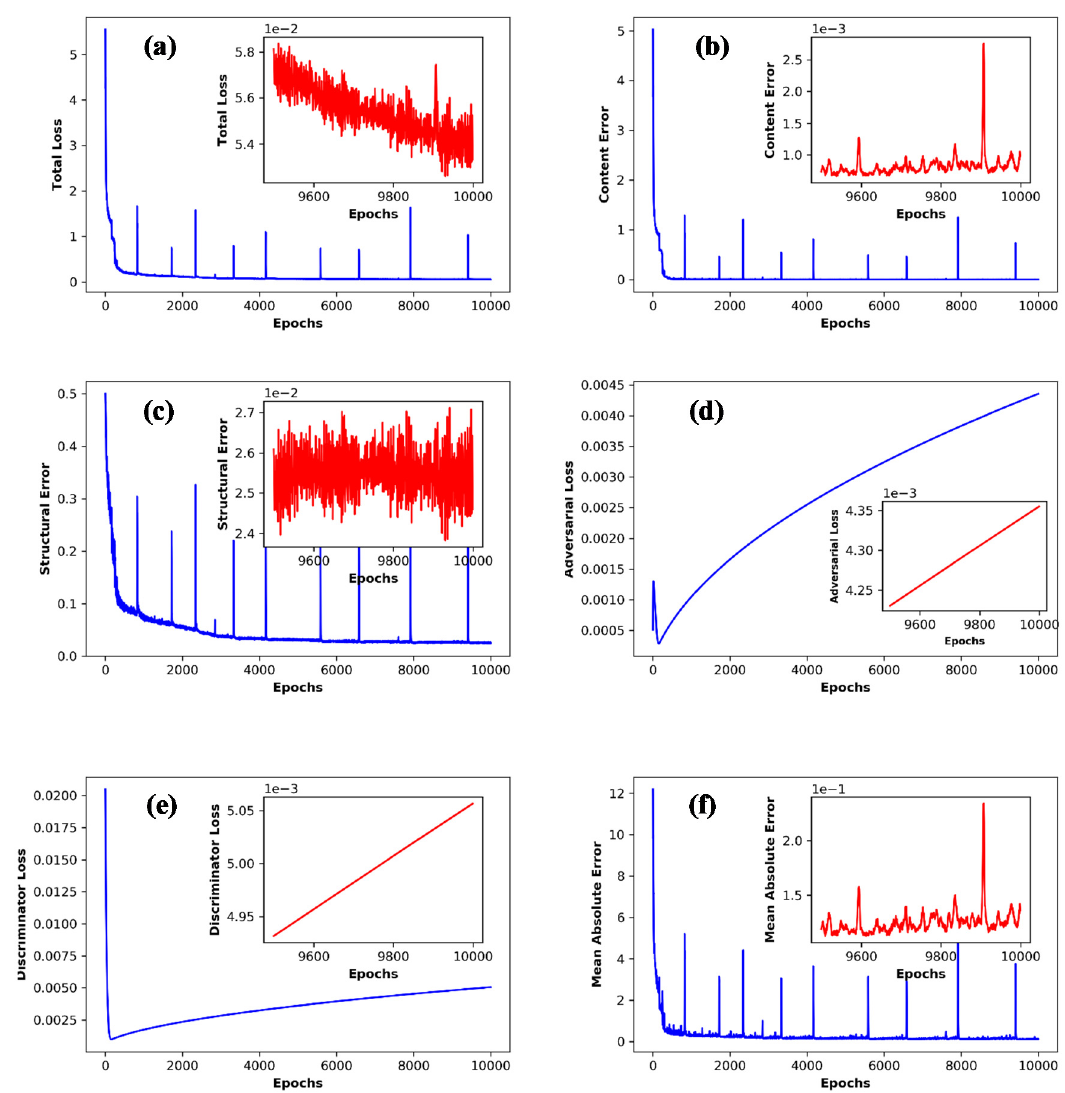
Figure 6. ( a ) Total loss of training, ( b ) content loss, ( c ) structural loss, ( d ) adversarial loss, ( e ) discriminator loss, ( f ) mean absolute error of the training.